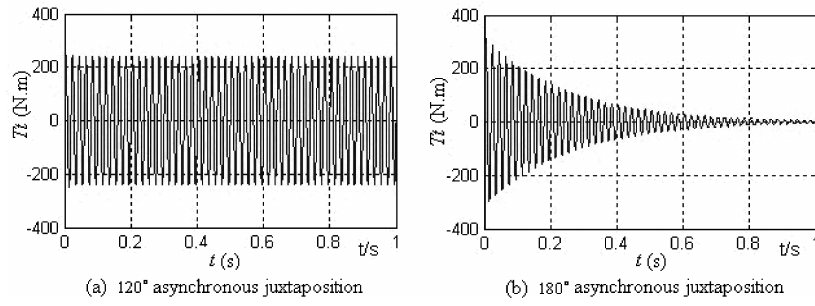
Fig. 6. Characteristics of the electromagnetic torques under the asynchronous